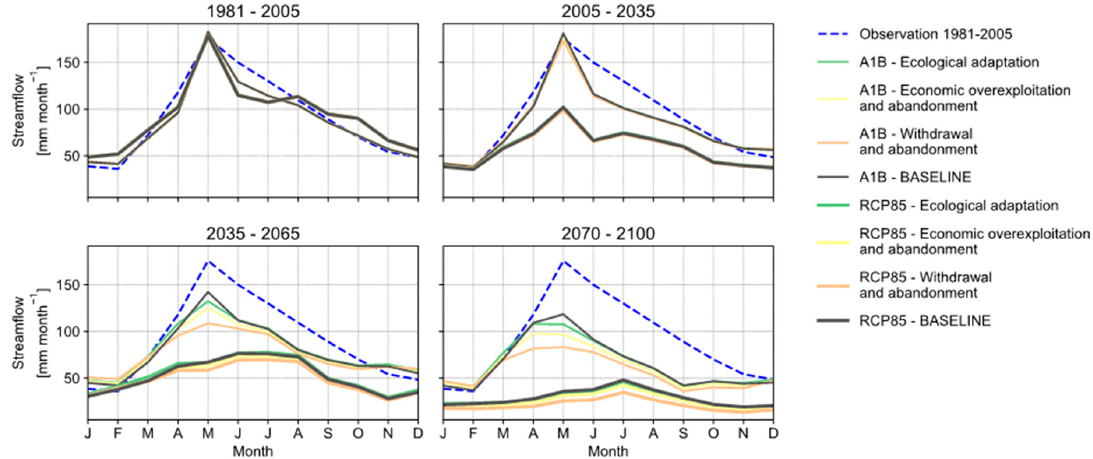
Figure 4. Seasonal streamflow under different management options.